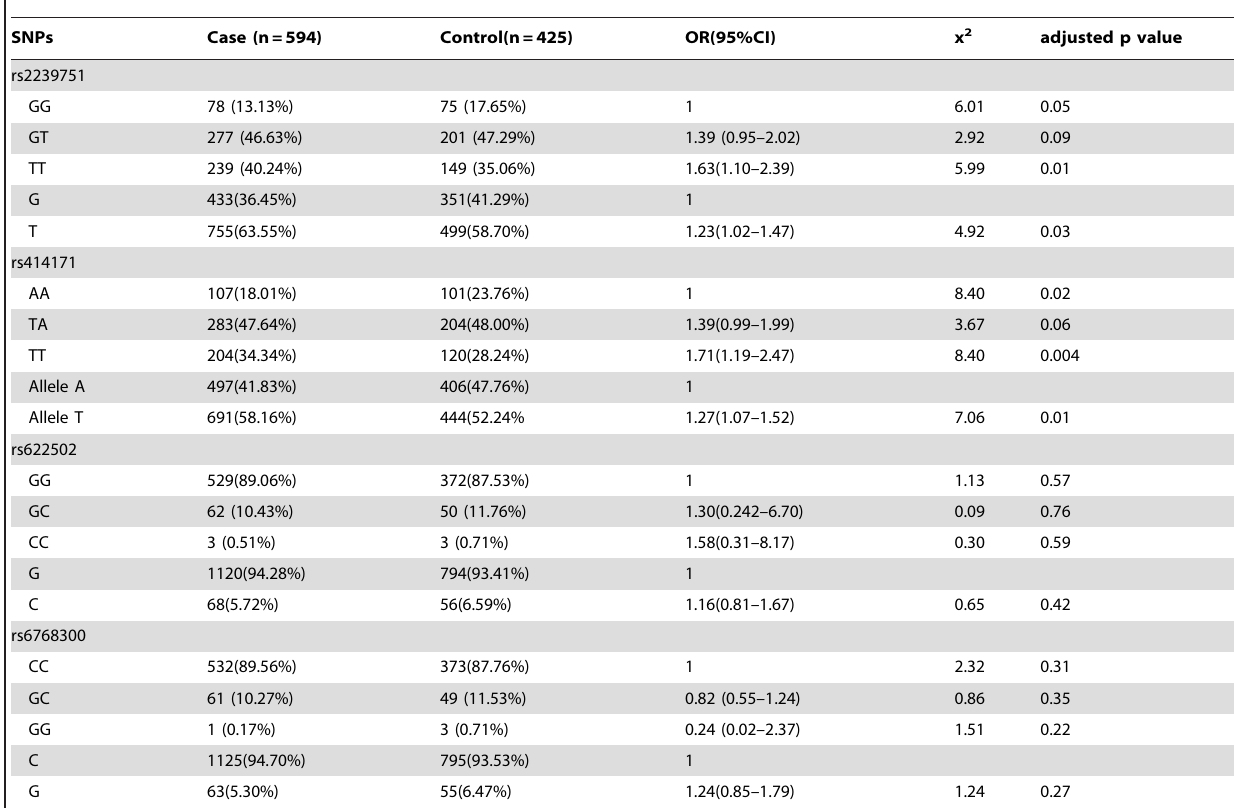
Table 3. CISH genotype and allelic frequencies for association with persistent HBV infection in Chinese Han